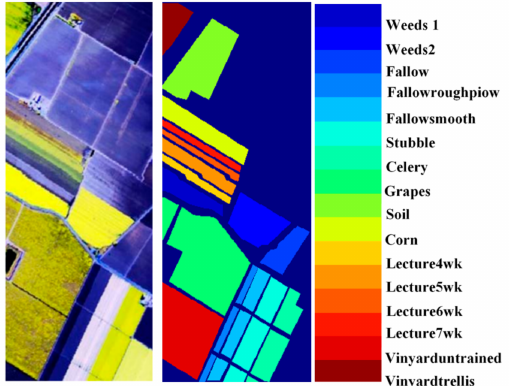
Figure 5. The false color image and ground truth map of the Salinas dataset. The original image size is 512 × 217